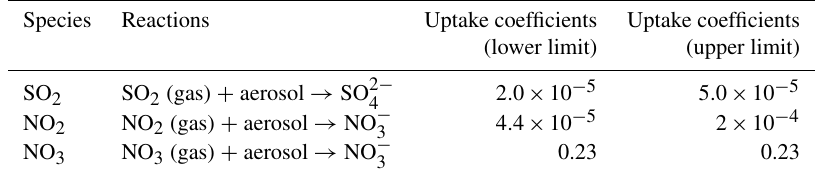
Table 2. Reactions and uptake coefficients added in this study.